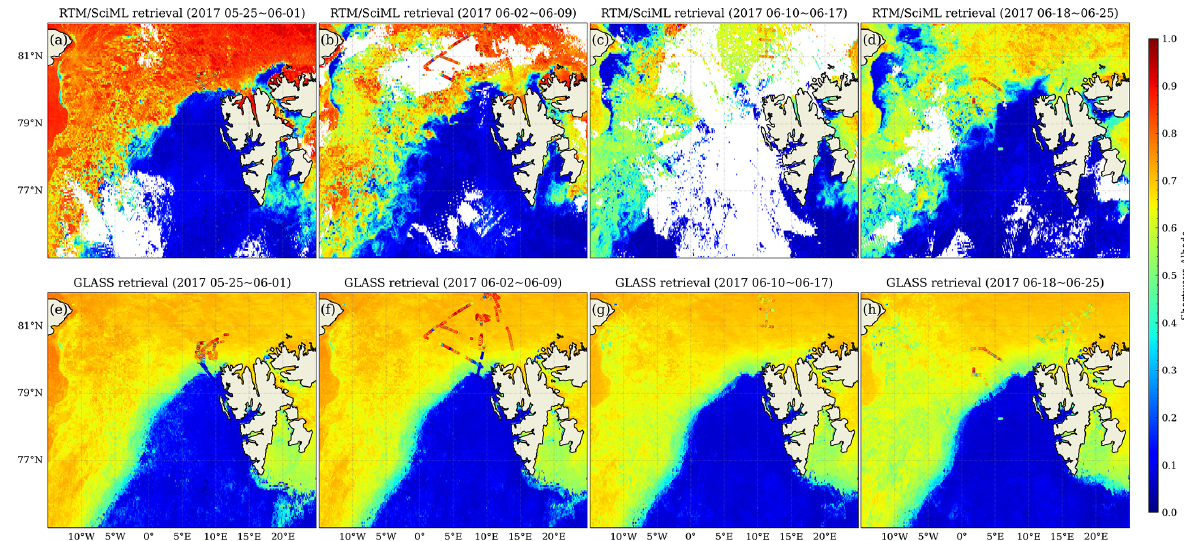
Figure 18. Maps of albedo derived using RTM–SciML (MODIS) and the direct-estimation algorithm (AVHRR data, Liang et al., 2021) averaged during 8d periods. In the top row, empty regions represent areas obscured by cloud throughout the 8d periods. The pyranometer measurements from the ACLOUD campaign are superimposed over the retrieval maps for the following flights: (a, e) the flight on 31 May 2017; (b, f) the flights on 2, 4, and 8 June 2017; (c, g) the flight on 14 June 2017; and (d, h) the flights on 18, 20, 25, and 26 June 2017.